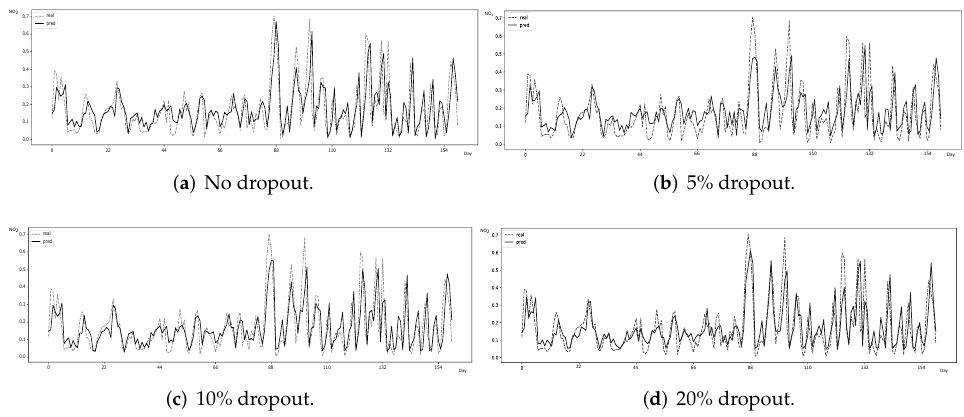
Figure 19. Predicted versus actual normalized output values for diverse dropouts added to all layers.